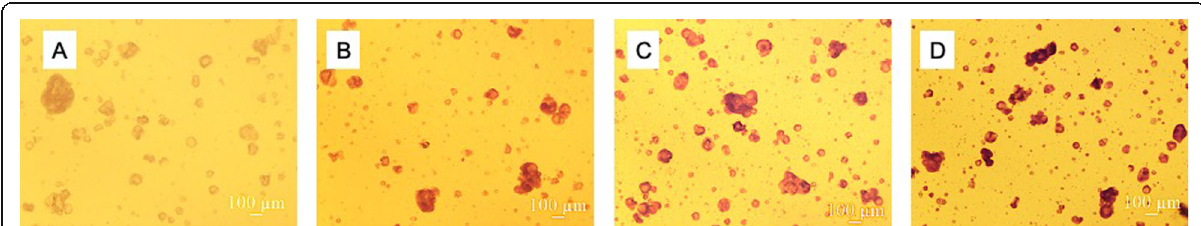
Fig. 8 Optical light microscope images at 40x magnification depicting the microstructures of diluted feed dispersions with 1.0 PPI:sucrose with 0% ( A ), 0.5% ( B ), 1% ( C ), and 1.5% PP addition ( D )